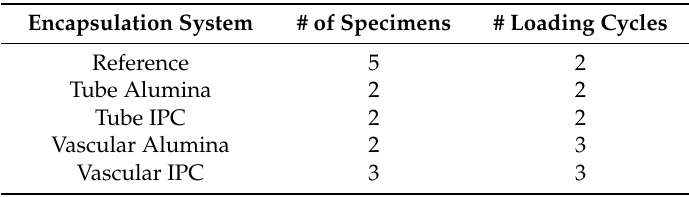
Table 8. An overview of the specimen, their code and the number of carried out loading